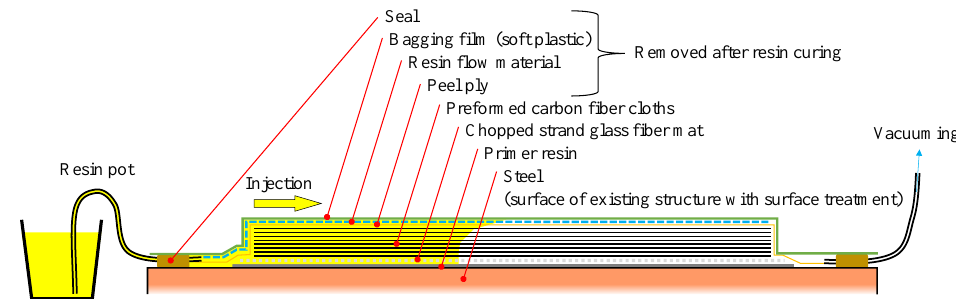
Figure 1. CFRP strengthening method by VaRTM.